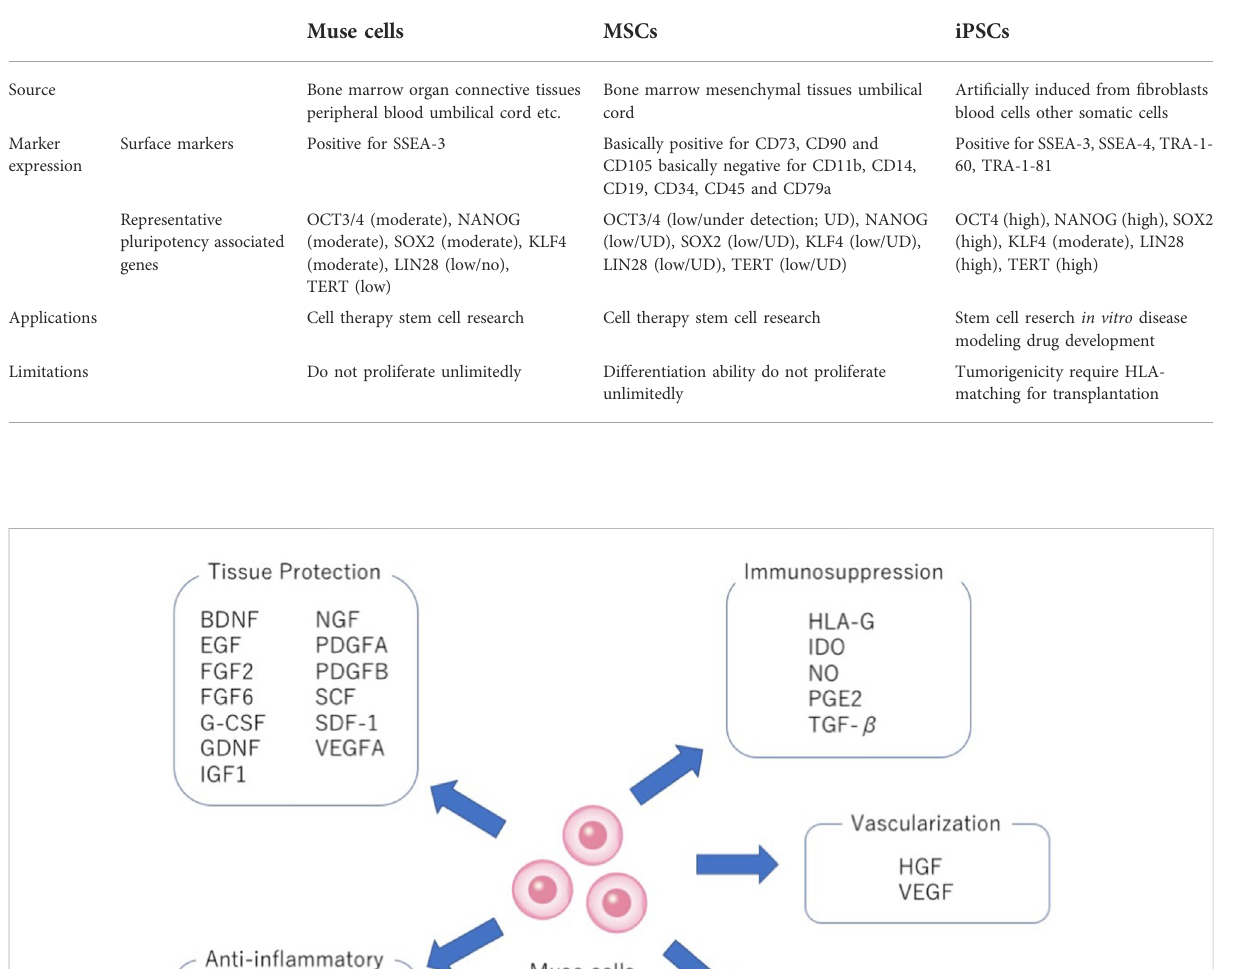
TABLE 1 Difference between muse cells vs. iPSCs vs.